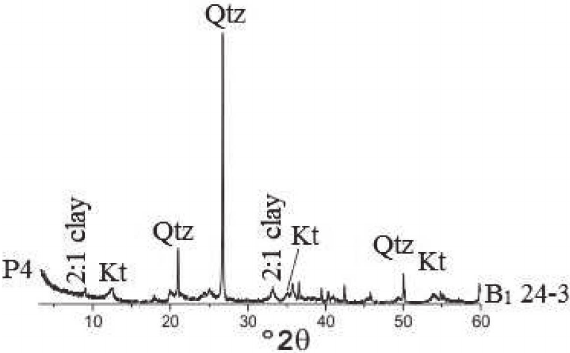
Figure 6. X-ray diffractogram of plinthites of the B 1 horizon of the poorly drained P4: Kt, Kaolinite; Qtz, Quartz; and 2:1 clay mineral. Table 3. Values of Silicium-, Aluminum-, Iron-, and P-oxides extracted by the sulfuric acid attack, Ki and Kr indexes, Fe-dithionite (Fe (d) ), Fe-oxalate (Fe (o) ), F (o) /F (d) ratio, and Al 2 O 3 /Fe 2 O 3 of four soils studied in